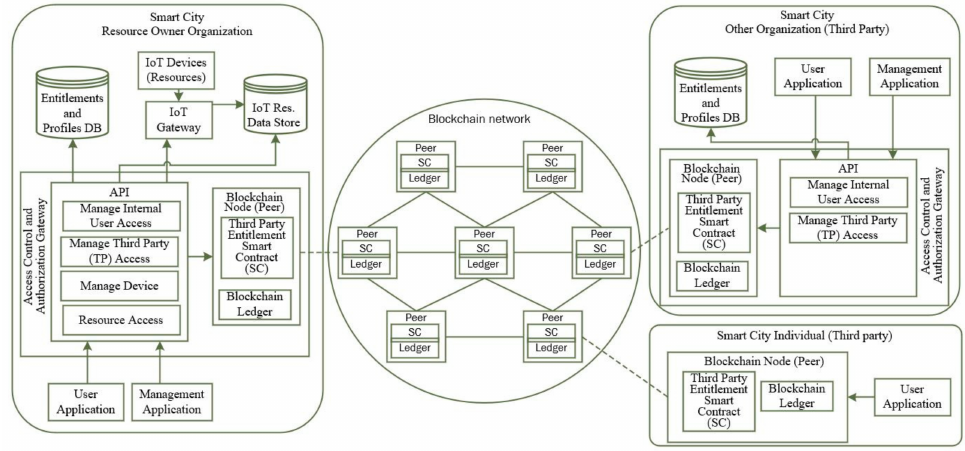
Figure 4. Proposed entitlement-based blockchain-enabled access control architecture for Smart City IoT.